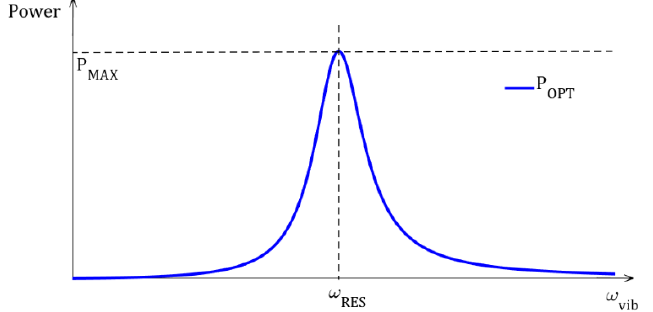
Figure 3. Typical trend of the maximum average power, 𝑃 (cid:3016)(cid:3017)(cid:3021) , as a function of the vibration fre- quency, 𝜔 (cid:3023)(cid:3010)(cid:3003) , according to Equation (6), for a standard single coil electromagnetic harvester. ω VIB , according to Equation (6), for a standard single coil electromagnetic